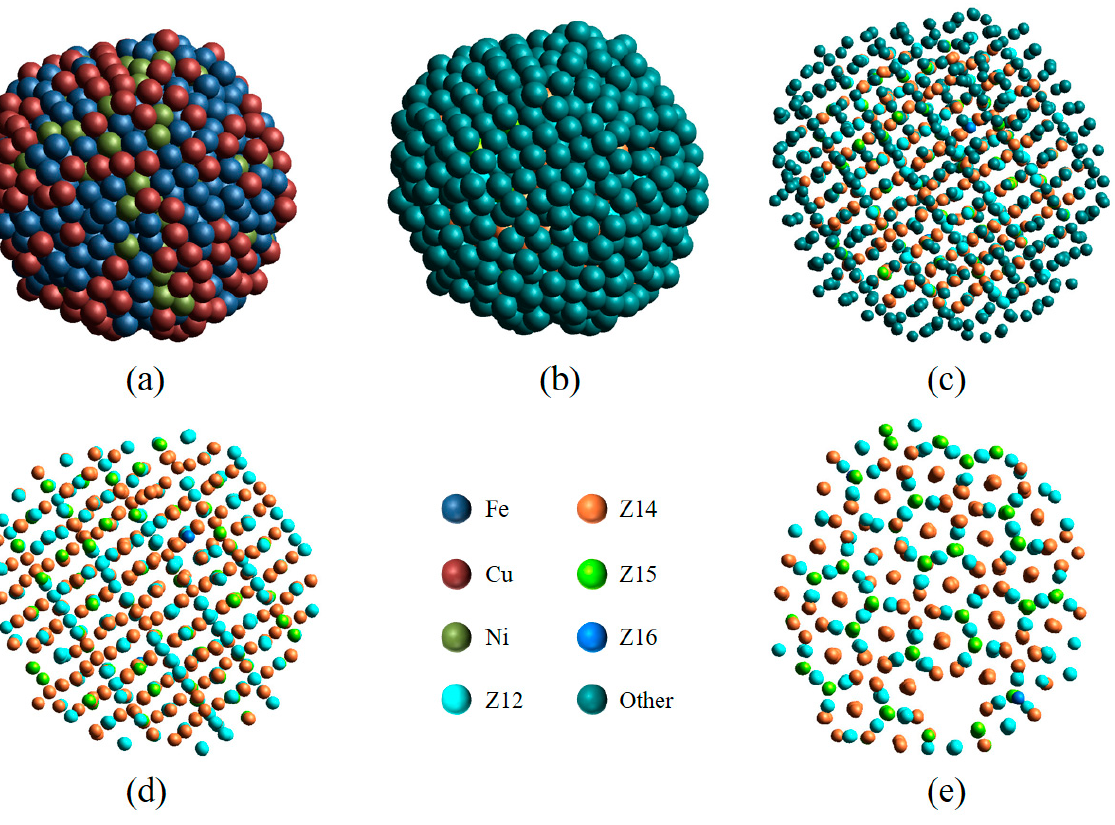
Figure 4. Structural analysis of a Fe 70 Cu 15 Ni 15 nanoparticle. The 3D view is color-coded by element type ( a ) or by LaSC type ( b – e ). The radius of atoms in ( b , e ) is double that of atoms in ( c , d ). ( d , e ) Only four TCP (Z12, Z14, Z15, and Z16) atoms retained.